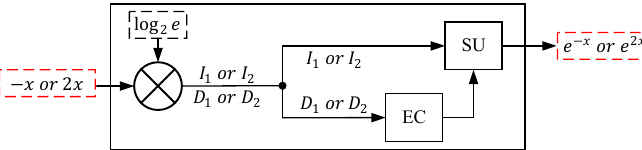
Figure 10. The architecture of computing exponential